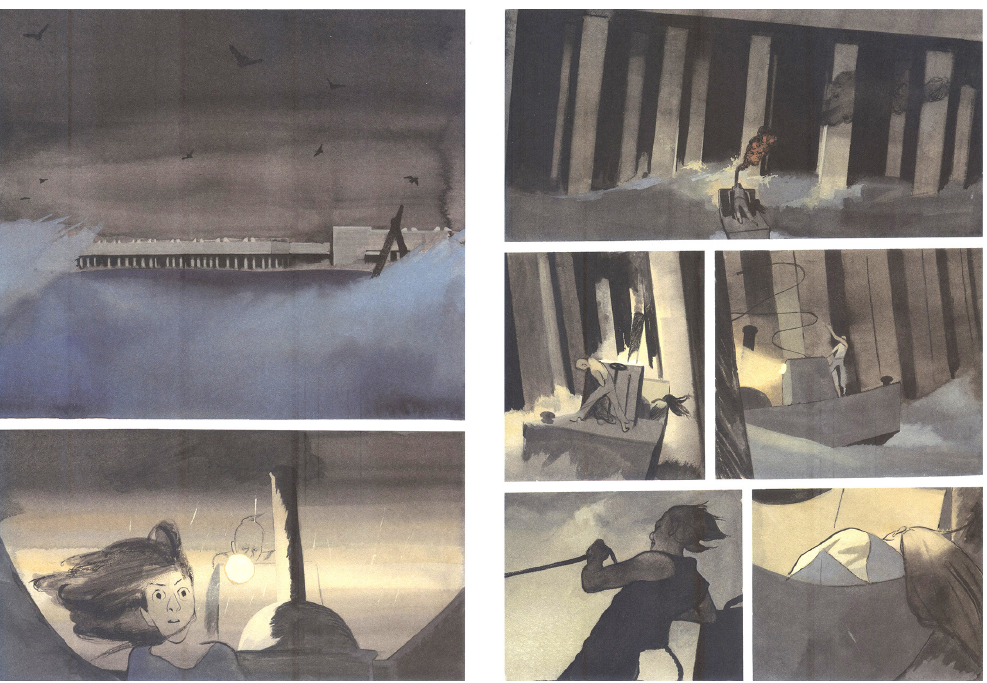
Fig. 4 Manuele Fior, Approaching Le Corbusier’s Hospital in Venice (Fior, 2019, pp. 107, 109,